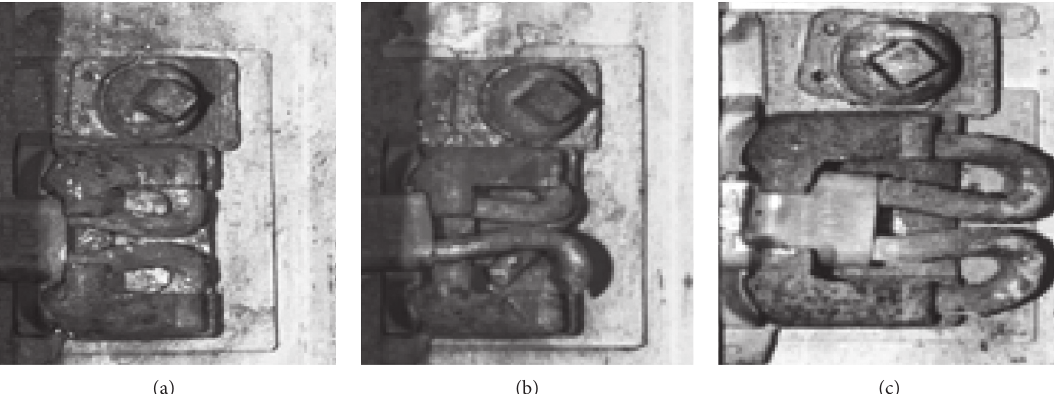
Figure 4: Common track fastener status. (a) The image of normal track fasteners. (b) The image of broken track fastener. (c) The image of loose track fastener.